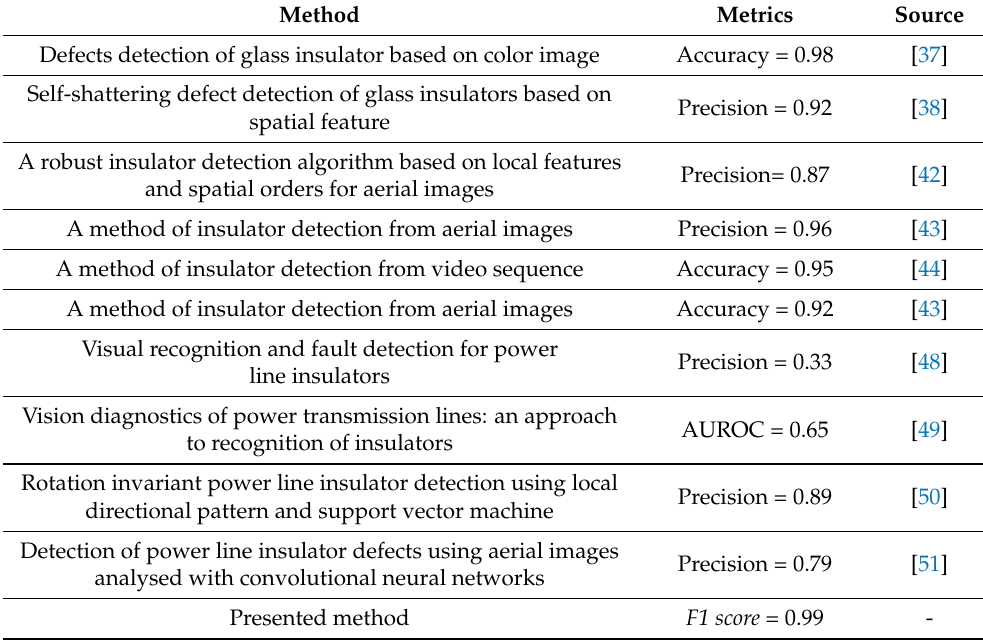
Table 1. Effectiveness of methods described in the section “Detection of power insulators—a bibliog- raphy review”. Method Metrics Source Defects detection of glass insulator based on color image Accuracy =